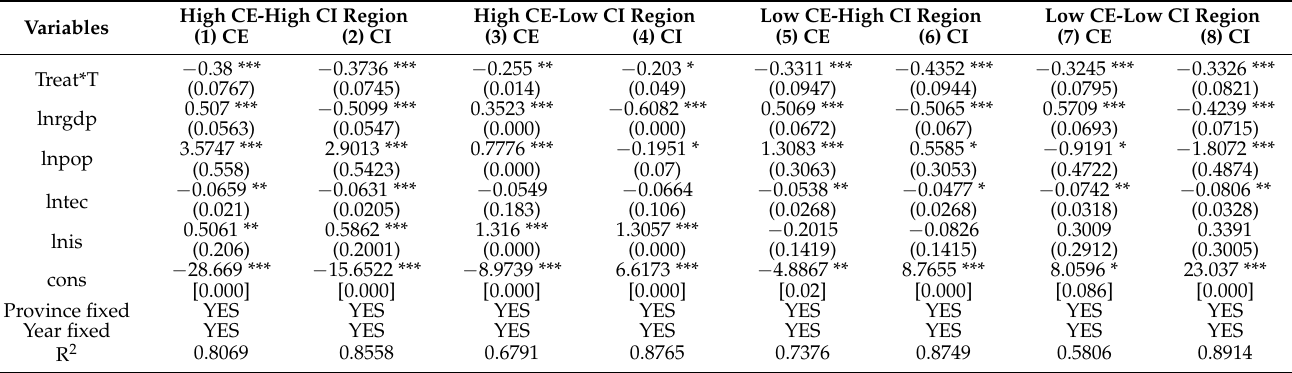
Table 7. Effects of carbon trading policies on carbon emissions and carbon intensity in different